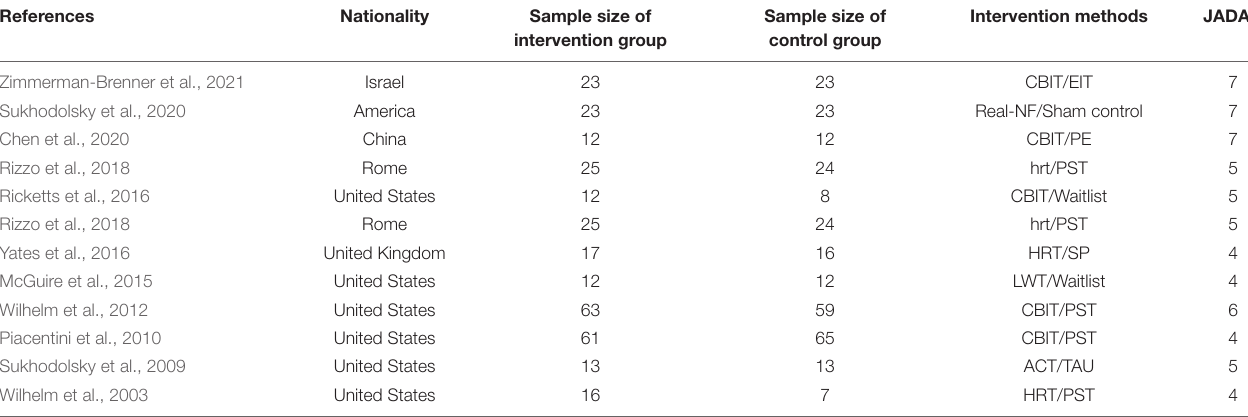
TABLE 1 | Basic characteristics of the included